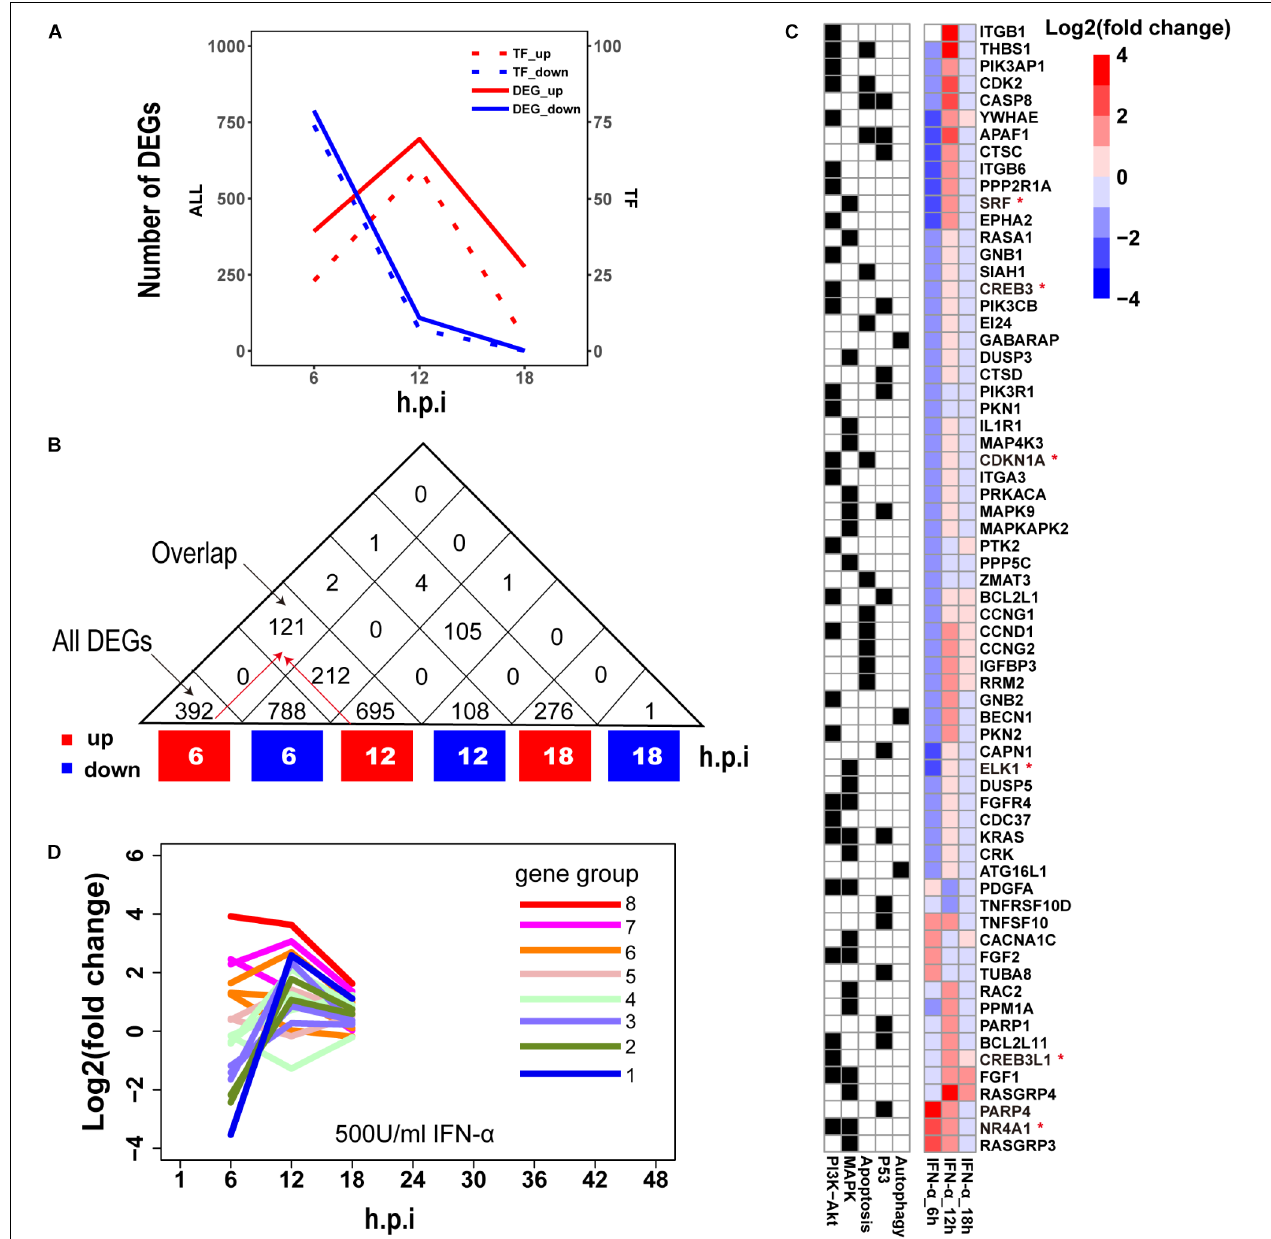
FIGURE 2 | Characterization of ASGs under interferon treatment. (A) The number of interferon stimulated DEGs. The red and blue colors represent up- and downregulated DEGs, respectively. All (left) means all of DEGs and TF (right) for TF DEGs. (B) The number of overlap DEGs between two separate sets of DEGs. The numbers in each square cell mean overlap gene count and the numbers in triangle cell represent total of up- or downregulated DEG at indicated times. Please find an overlap gene count following red arrows. (C) Dynamic expression profiles of survival- and death-related ASGs. In the left, black color means existence of gene in corresponding pathways, and white for absence. In the right, each cell represents fold change of gene expression with log2 transformation. The abbreviations PI3K-Akt, MAPK, Apoptosis, P53 and Autophagy denote PI3K-Akt signaling pathway, MAPK signaling pathway, Apoptosis pathways, P53 signaling pathway, and regulation of autophagy, respectively. The genes with red star ( ∗ ) are TFs. (D) Expression trends of the 1819 ASGs under interferon treatment. Lines with different colors represent eight big gene groups, each of which is clustered into small gene clusters with the same